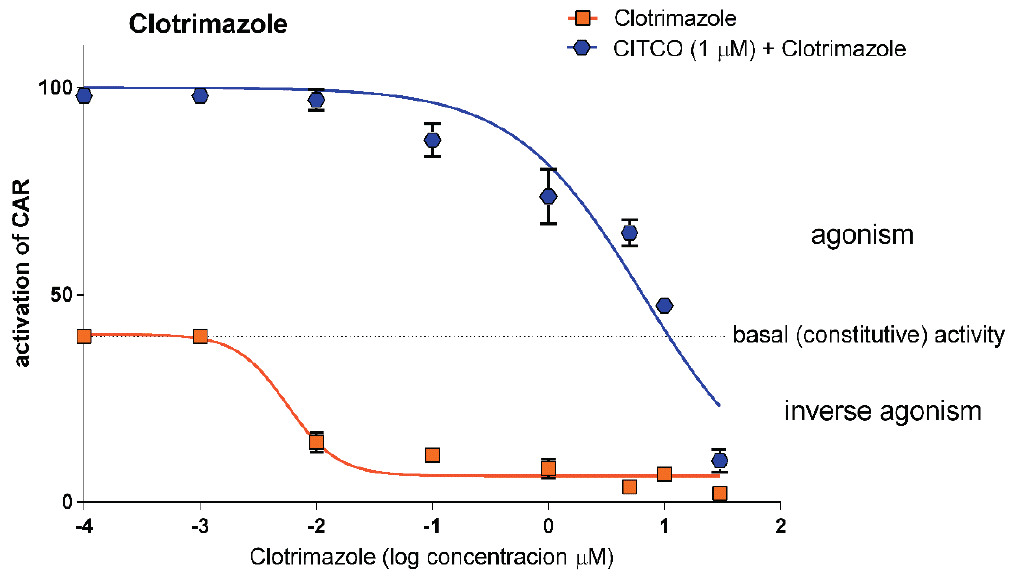
Figure 5. Effect of clotrimazole on CAR LBD activity in the TR-FRET LanthaScreen TM CAR Coactivator Assay. Clotrimazole in a serial dilution was tested in inverse agonistic or antagonistic modes together with the prototype CAR agonist CITCO (1 μ M concentration) using the TR-FRET assay. Data are presented as the relative activation to background activity (set to 0%) and to the effect of CITCO (1 μ M) set as 100% activation. The dotted line represents constitutive activity of CAR LBD (vehicle-treated samples). Data are presented as the means and S.D. from three independent experiments ( n = 3).